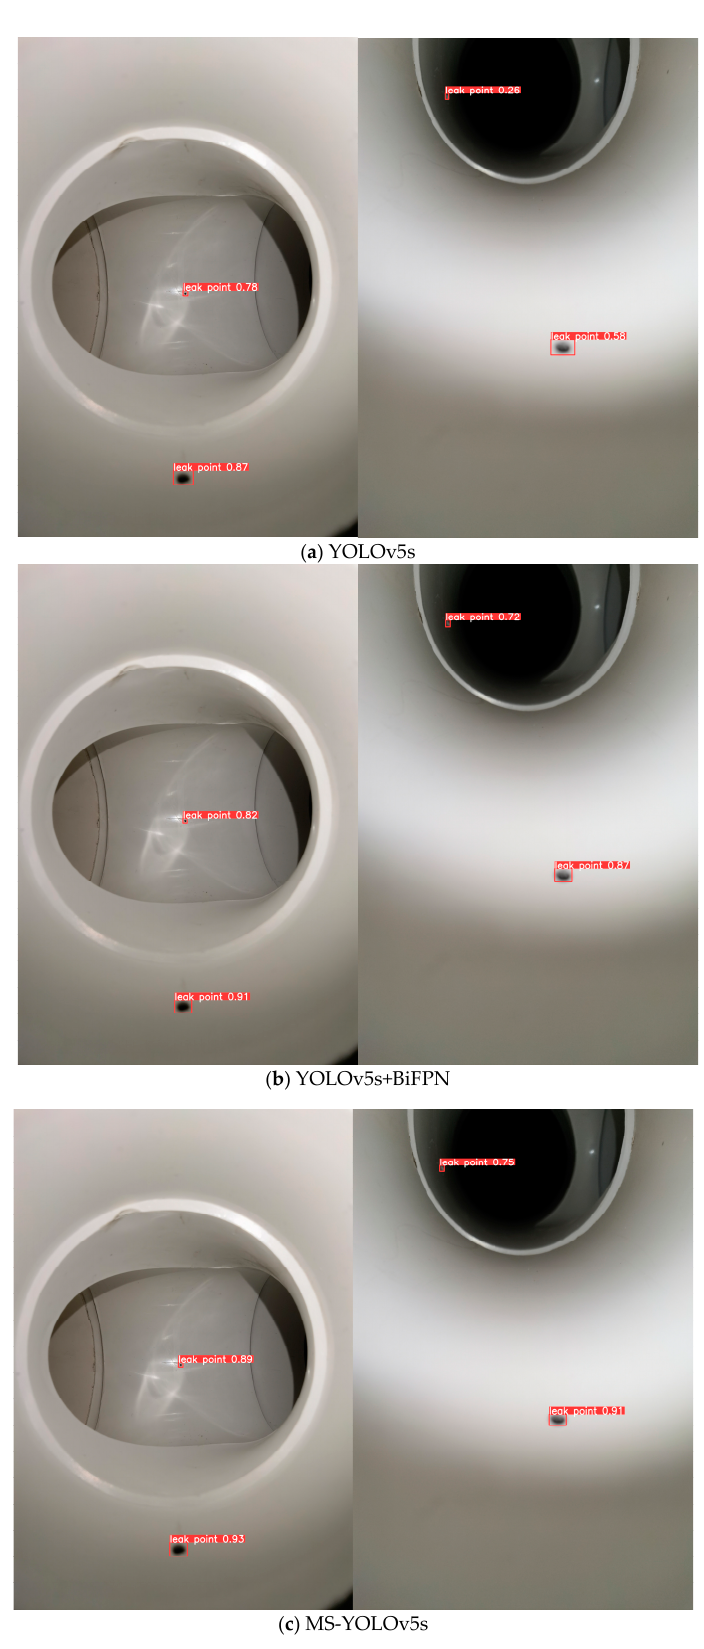
Figure 15. Comparison of recognition results of each network model.